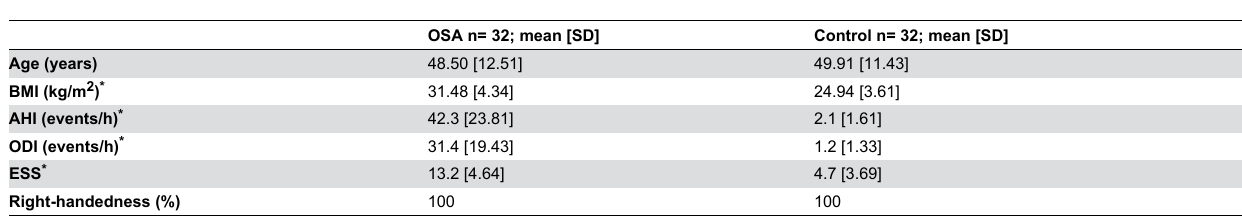
Table 1. Demographic Information.